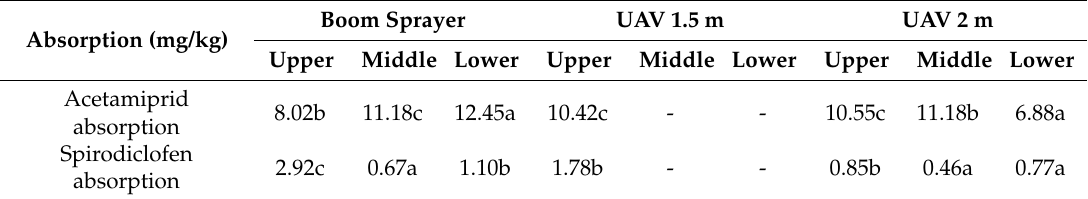
Table 6. Effect of cotton leaf attachment and